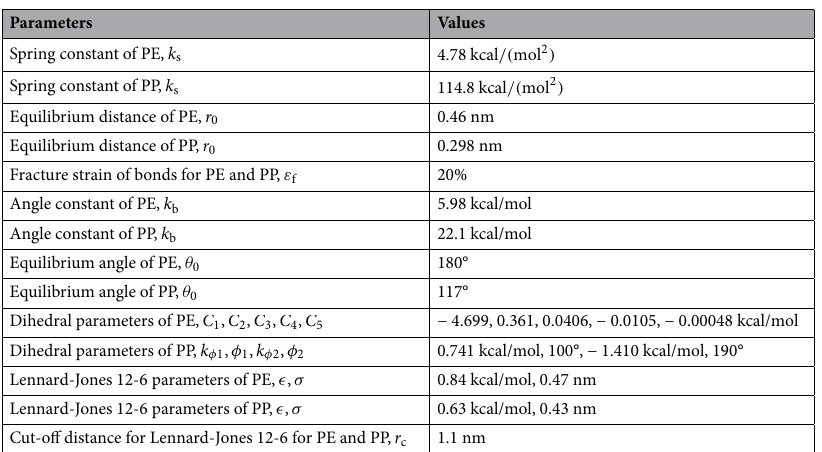
Table 1. Parameters of coarse-grained models for PE and PP 43